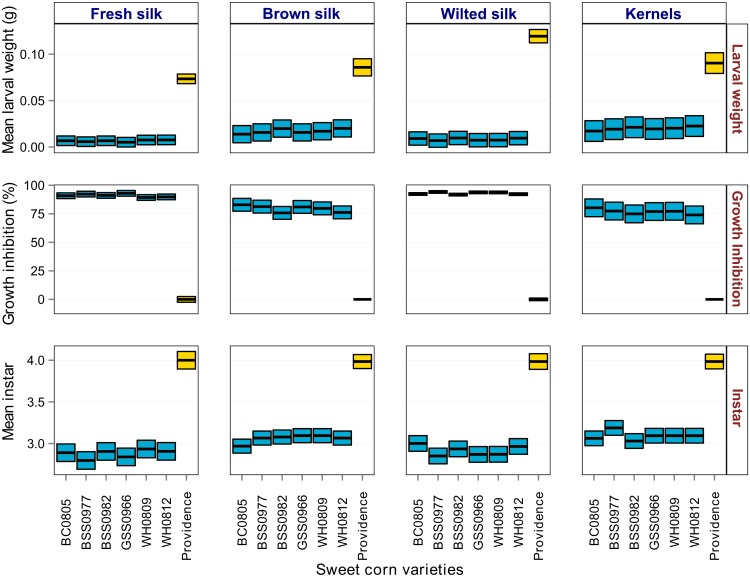
Results comparing control efficacy in relation to tissue toxicity among Bt and non-Bt sweet corn varieties from Maryland, USA in 2008.The mean weight, growth inhibition and instars of susceptible larvae feeding on different sweet corn tissues was broadly similar among the Cry1Ab expressing Bt hybrids (blue bars), and significantly different (Tukey’s HSD; α = 0.05) from non-Bt control hybrids (yellow bar). Black lines represent the mean values and height of bars indicate the upper and lower confidence levels (95%CI) estimated through Gaussian GLMs or ANOVA.